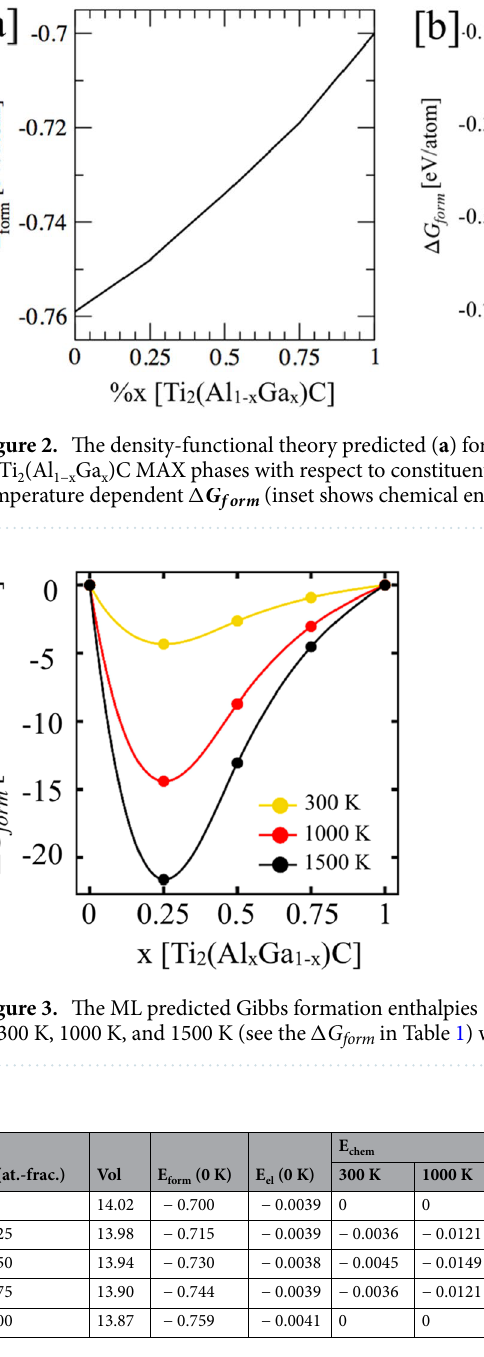
Table 2. The formation enthalpy and entropy contributions for Ti 2 (Al 1−x Ga x )C MAX phases. The electronic entropy was calculated from DFT 38–40 , the chemical entropy was estimated with